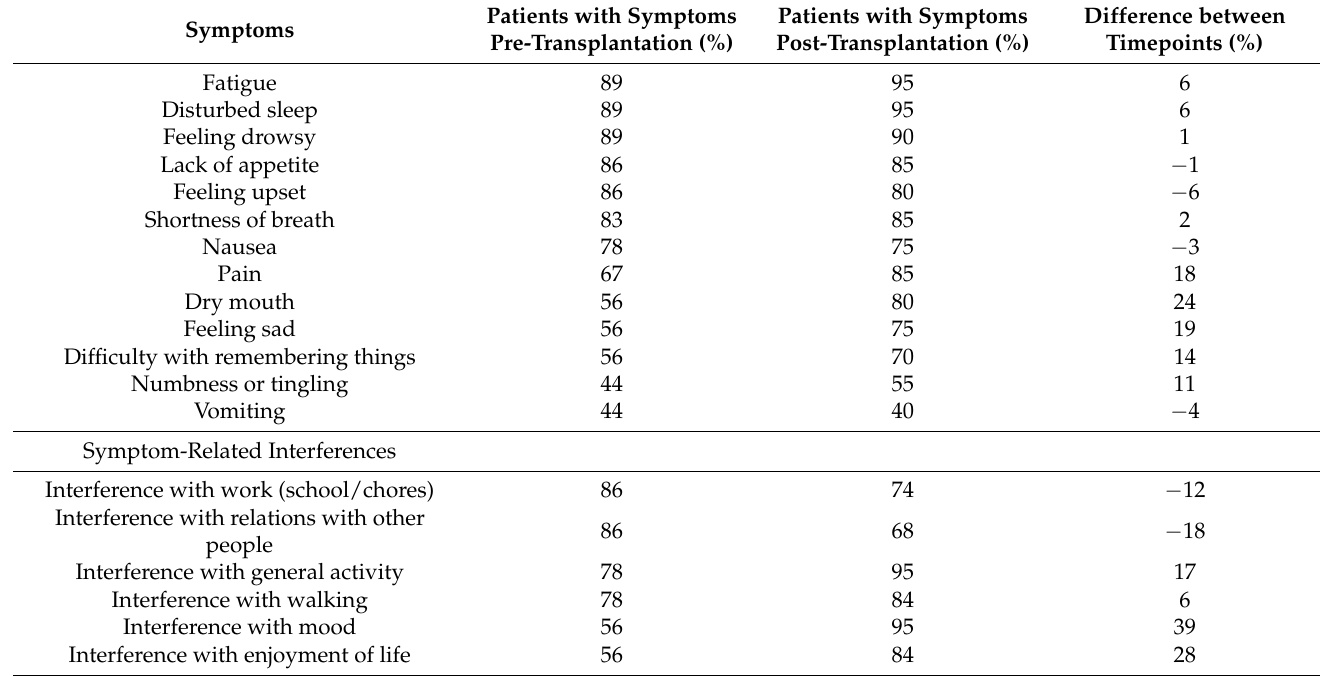
Figure 1. Summary of scores for each statistically significant symptom and symptom-related interferences before (“pre”) and after (“post”) the stem cell transplant. Scatterplots are overlaid by catseye plots illustrating the model-adjusted normal distribution of the means, with shaded ± standard error intervals. Scatterplots are randomly jittered slightly horizontally for clarity. The next component of assessing the symptom burden before and after transplanta- tion included comparing the prevalence of the symptoms between each time period. The Table 6. Percentage of patients experiencing symptoms and symptom-related interferences before three most common symptoms reported before and after transplantation were the same and after stem cell and included fatigue (median time of initial presentation: day − 5, range: day − 10 to + 10), disturbed sleep (median time of initial presentation: day + 3, range: day − 1 to + 17), and